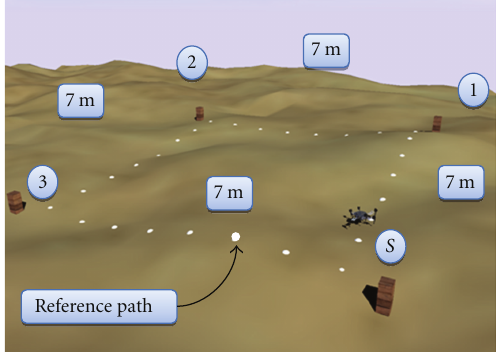
Figure 9: Terrain created using heightfield maps in a dynamic sim- ulation environment.